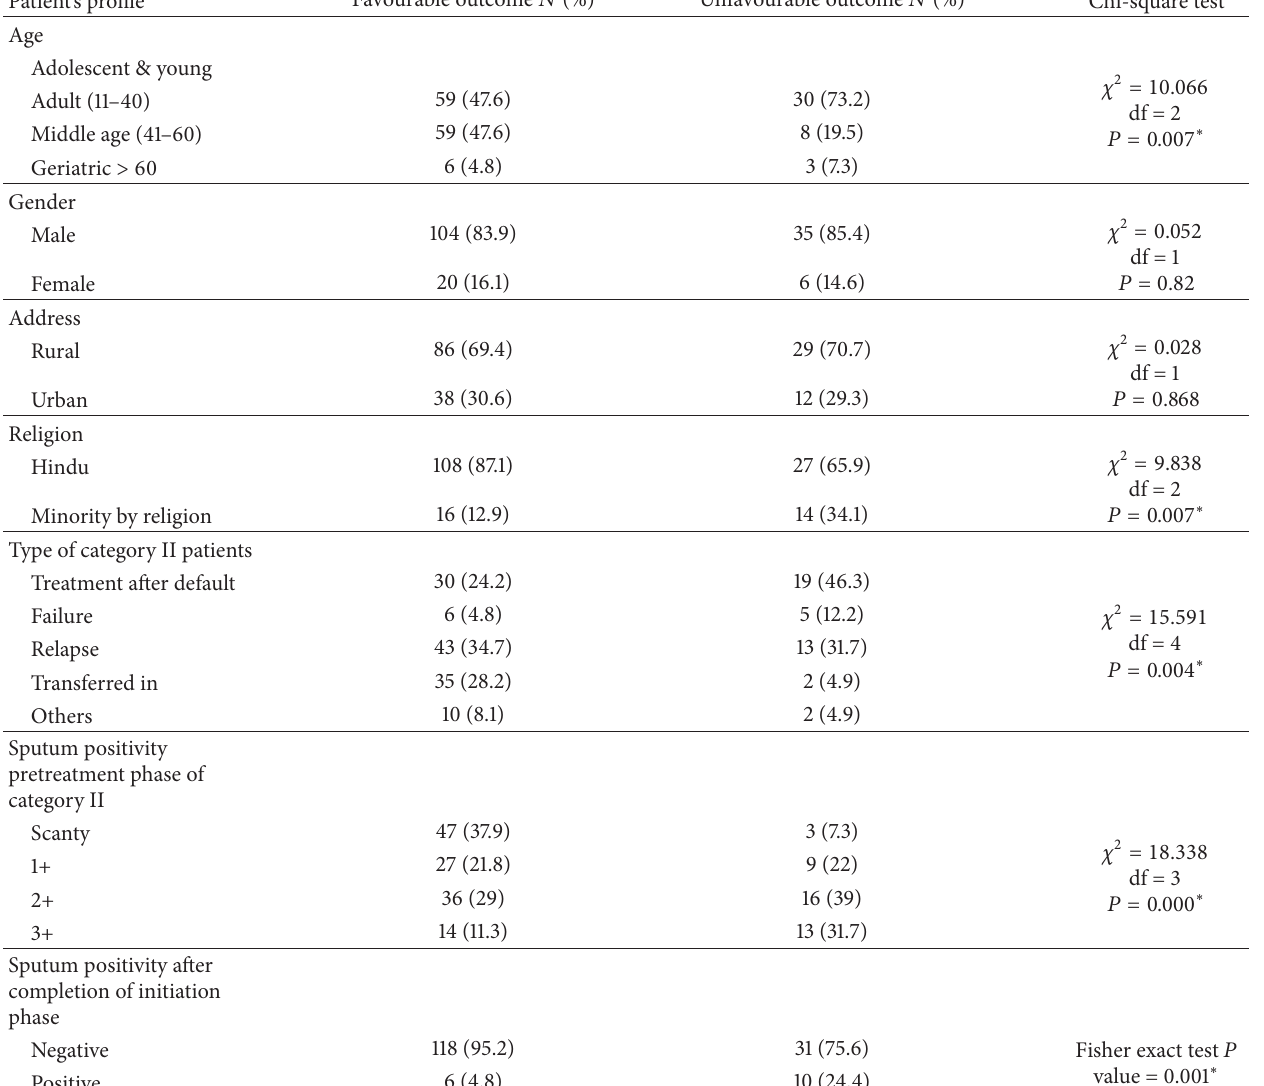
Table 1: Bivariate analysis between patient’s profile and treatment outcome. 𝑁 = 165